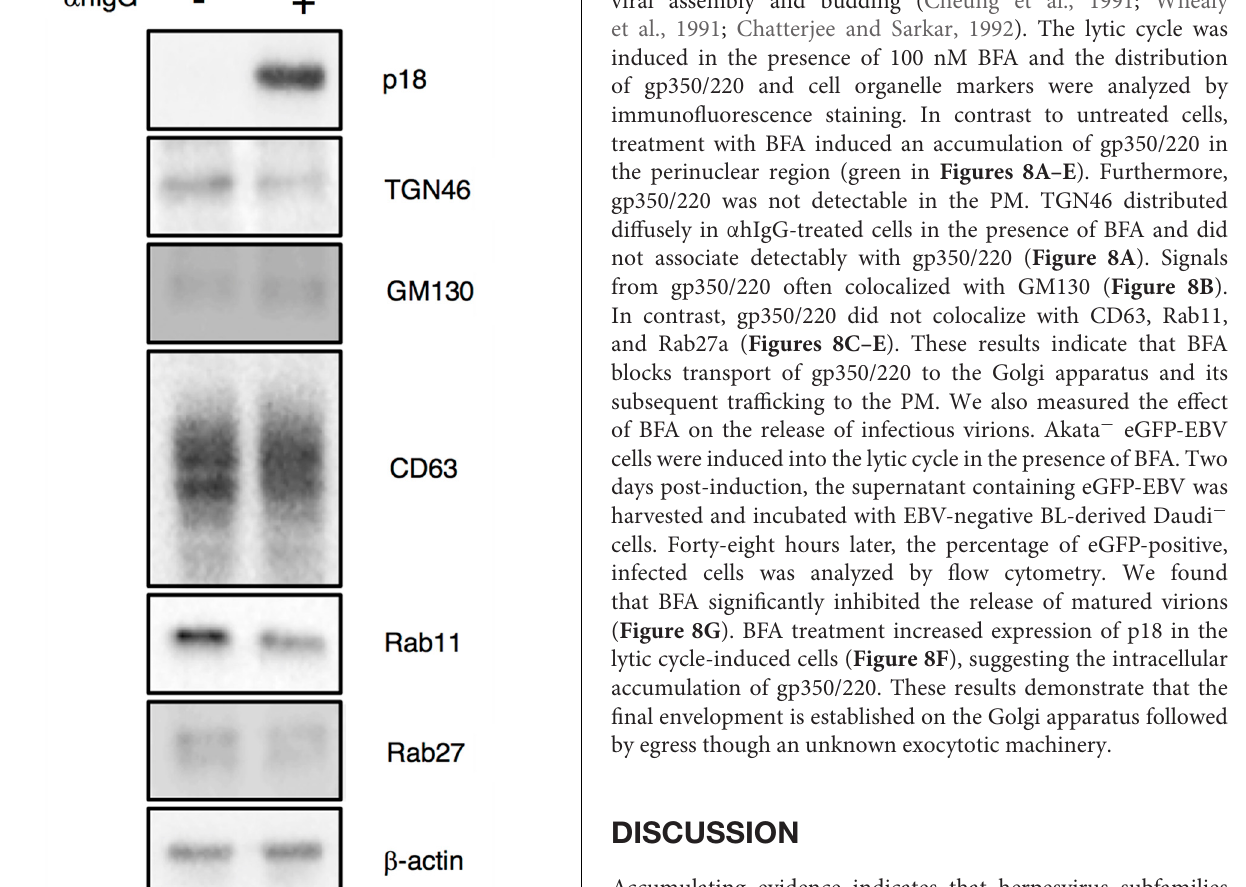
Zografou et al., 2012). Rab27a distributed in a speckled pattern